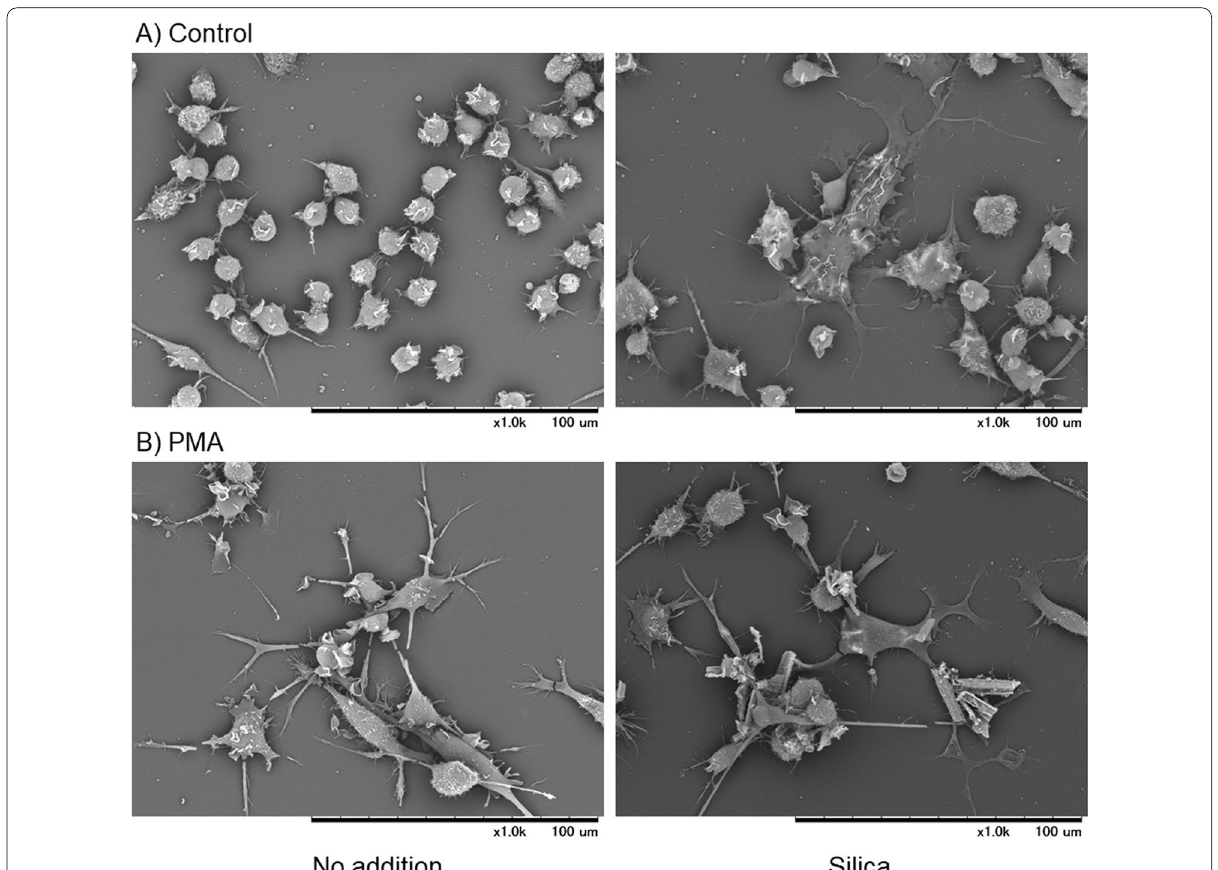
Fig. 2 Effects of silica microparticles (MPs) on the surface microstructure of control and phorbol 12-myristate 13-acetate (PMA)-treated HL60 cells. The control cells A and those simultaneously treated with silica MPs for 3 days B were fixed and subjected to scanning electron microscopy examination. Similar data were obtained from two additional independent experiments ( n =